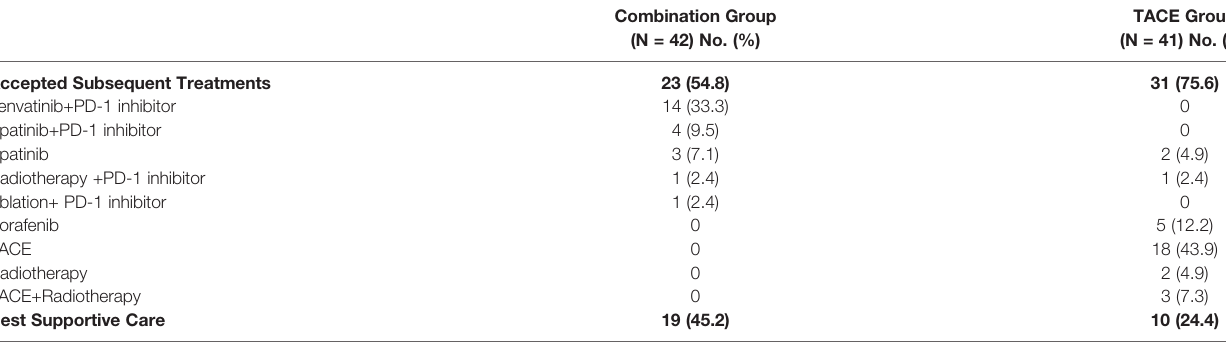
The bold values highlighted the factors with signi fi cant difference. Data are presented as n (%). TACE, transcatheter arterial chemoembolization; PD-1, programmed cell